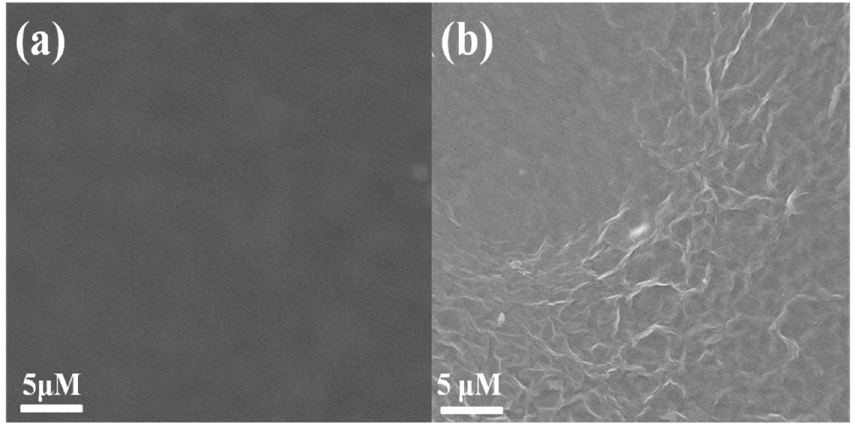
Figure 2. SEM images of ( a ) bare GCE and ( b ) p-Gly/rGO/GCE.